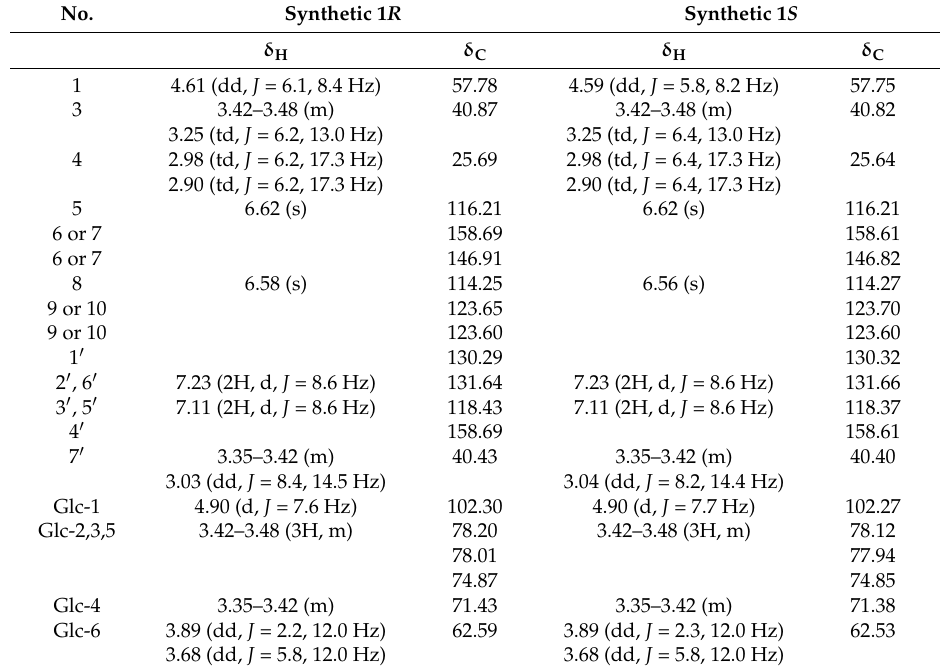
Table 2. NMR data for synthetic 1 R and 1 S in methanol- d 4 .